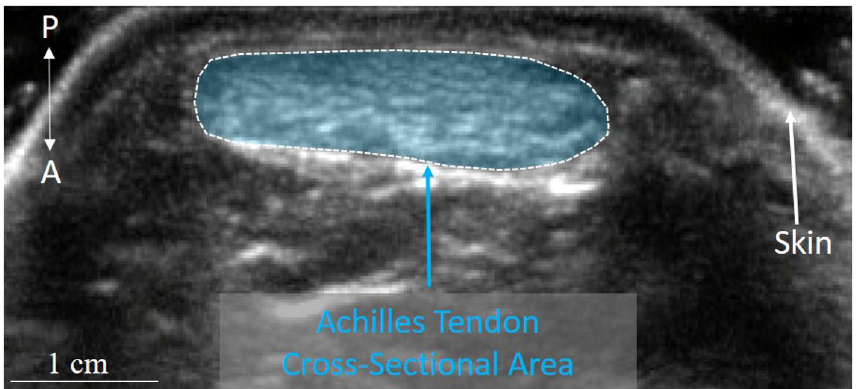
Figure 4. The cross-sectional area of the Achilles tendon measured using ultrasound. Example of the cross- sectional area of the Achilles tendon measured at the level of the malleoli using B-mode ultrasound. The area of the tendon outlined by the dashed white line and shaded in blue was calculated using ImageJ. A is anterior and P is posterior. The hyperechoic region anterior to the shaded ellipse around the tendon is Kager’s fat